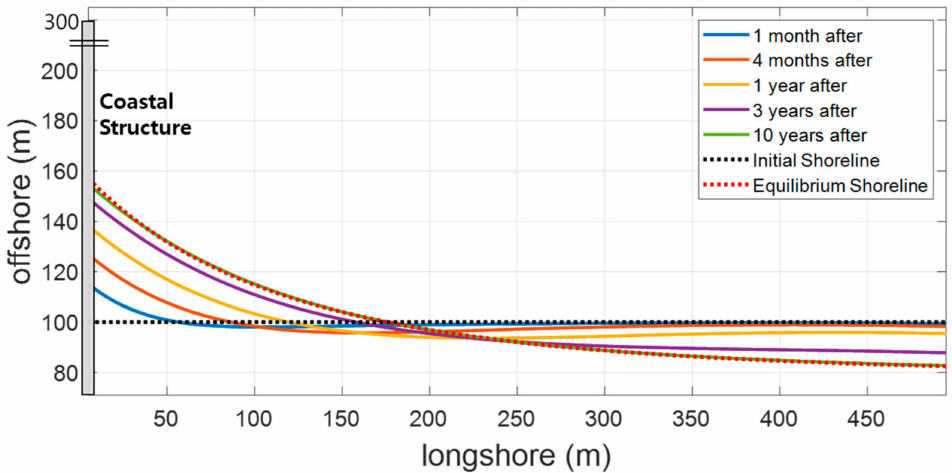
Figure 6. Shoreline change model of convergence to equilibrium shoreline.